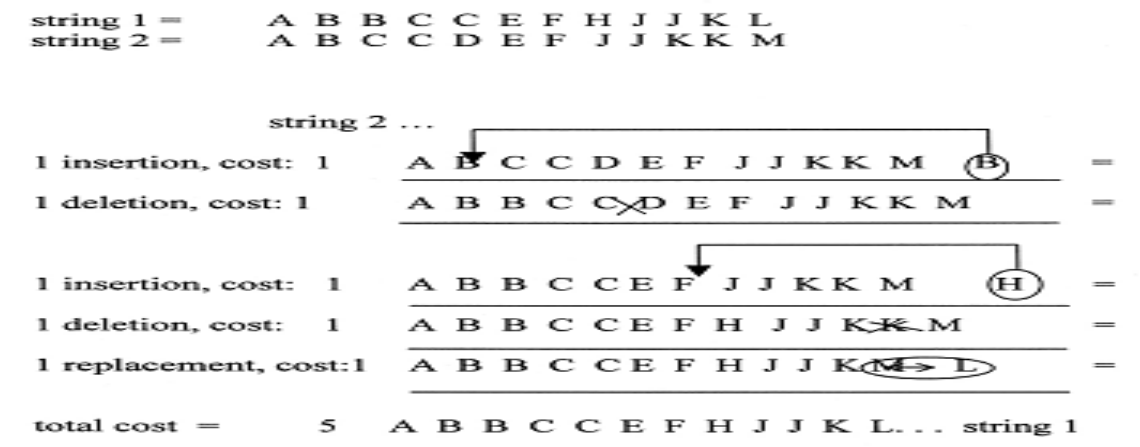
Fig. 3b : Minimum necessary changes (total cost) to change string 2 into string 1. For the distance measure to be meaningful, the minimum number of edits counts: the distance is three, as the fol- lowing three edits are necessary to change one string into the other. Of course, it is always possible to obtain the same result with more edits, but this would be arbitrary.